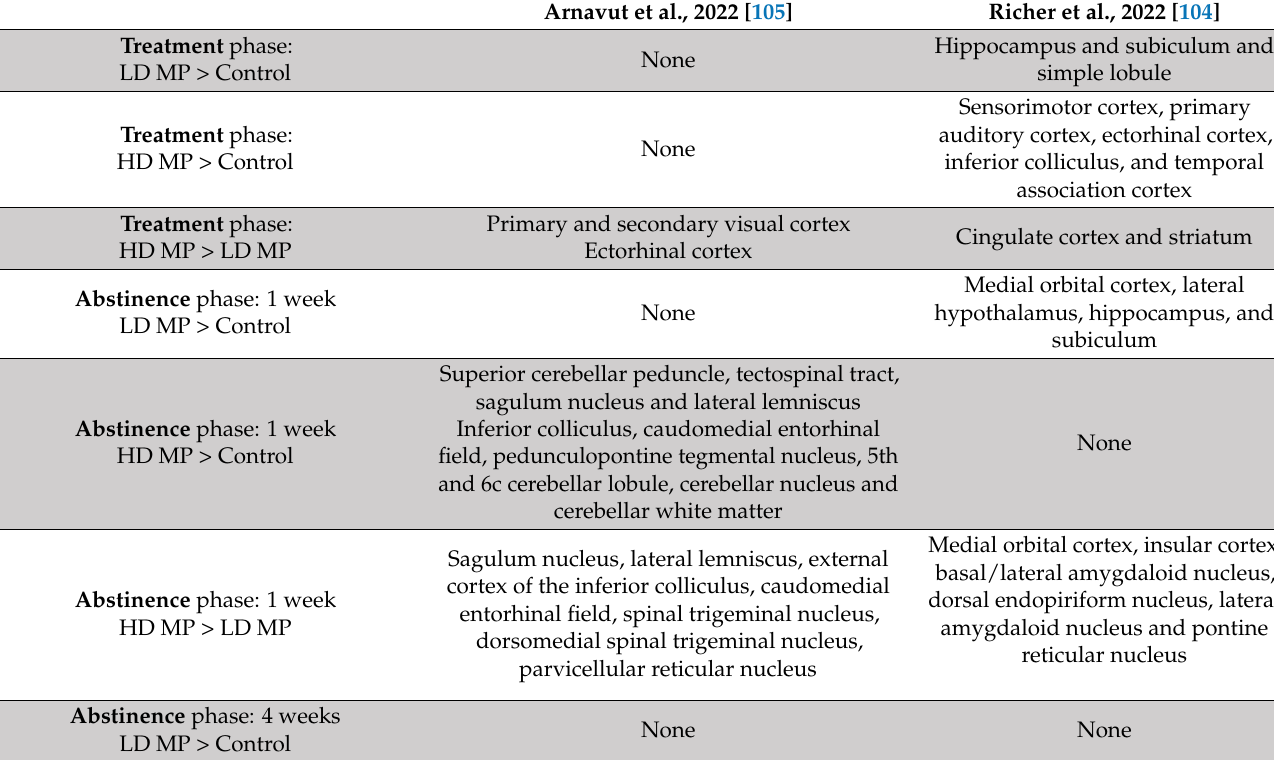
Table 6. Summary of the BGluM changes following oral MP treatment. Areas of activation are indicated in red and areas of inhibition are indicated in